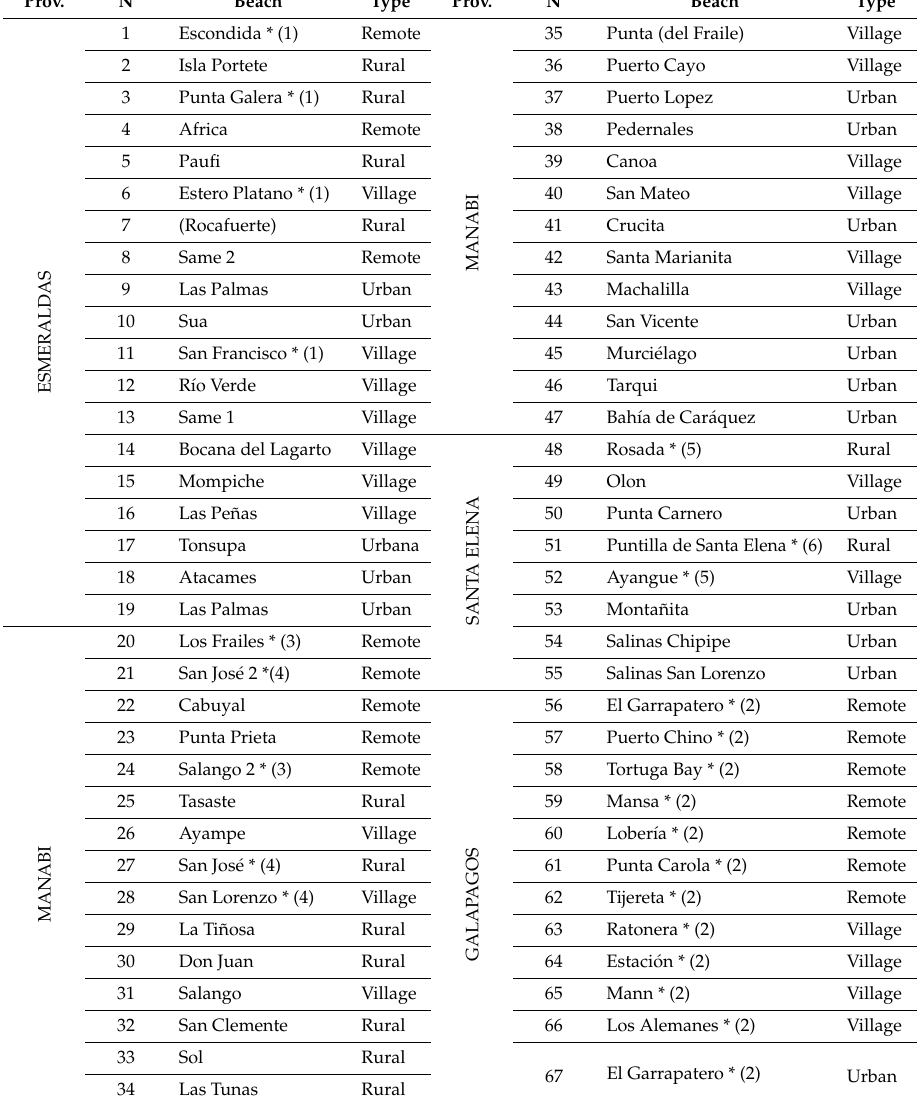
Table 3. Location and main characteristics of investigated sites: name, province, type and protection feature.